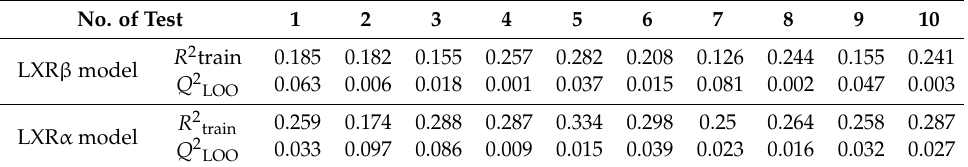
Table 4. R 2 train and Q 2 LOO values of QSAR models after ten Y-randomization